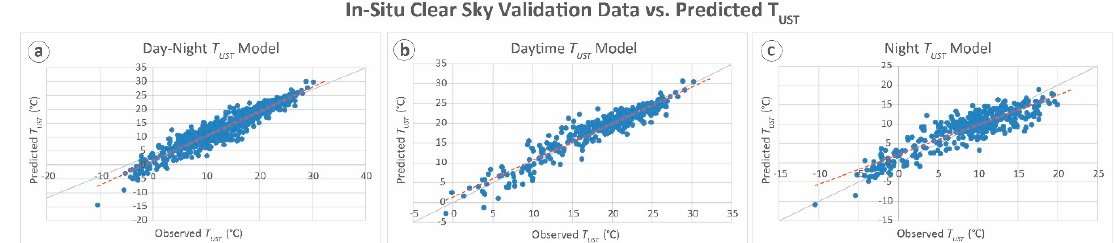
Figure 7. In situ understory temperatures vs. predicted T ust values estimated using the top-ranked models for ( a ) day and night; ( b ) daytime; and ( c ) night. Data are the randomly withheld clear-sky MODIS overpasses of the study area over the duration of the study period.